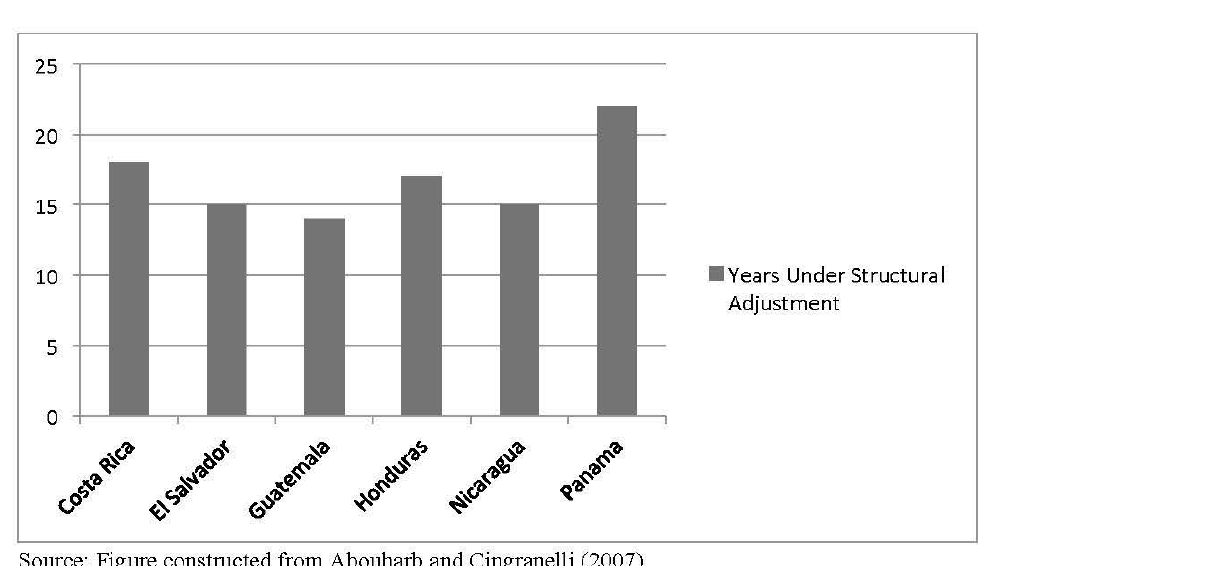
Source: Figure constructed from Abouharb and Cingranelli (2007)